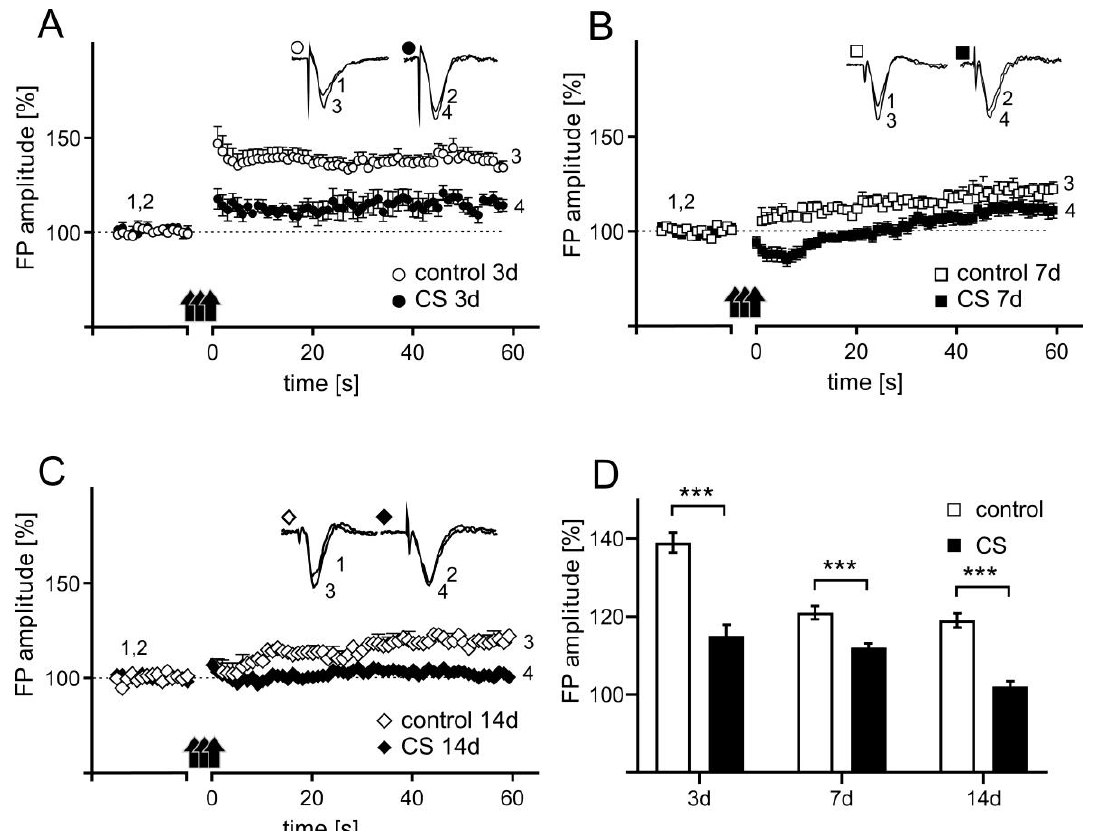
Figure 5. Crowding stress-evoked decrease in LTP magnitude in the rat FC. Plots of the time course of FP amplitude (±SEM) before and after LTP induction showing the influence of CS on LTP after 3 days of CS ( A ) and after 7 ( B ) or 14 days of CS ( C ). The data are presented as group means ± SEM for controls (non-filled shapes) and different stress groups: 3 days (filled circles, n = 8), 7 days (filled squares, n = 19), and 14 days (filled diamonds, n = 18). Insets in A, B, and C show the superposition of averaged FPs recorded in representative experiments at the times indicated by numbers. Black arrows in A, B, and C denote the TBS. ( D ) Comparison of the CS-evoked changes LTP magnitude. Data calculated as a percentage of changes relative to baseline control values (100% indicated as a dashed line). *** p < 0.0001.